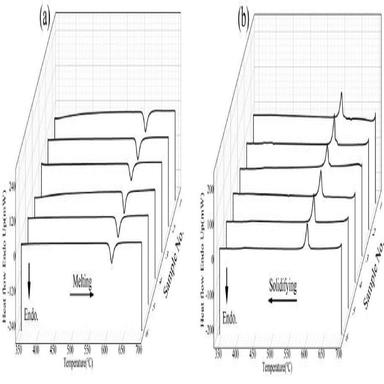
DSC curve for melting(a) and solidifying(b) of samples.